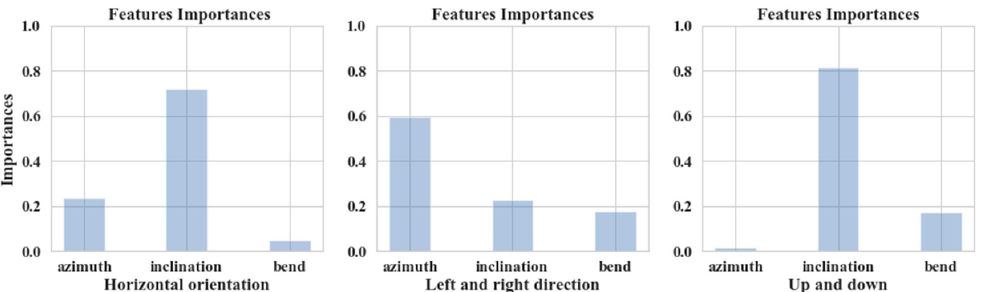
Figure 5. Predicted feature importance.